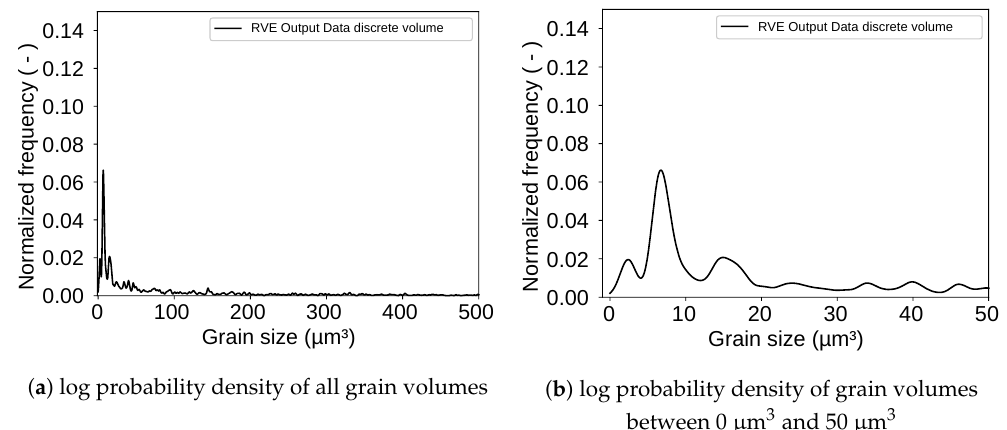
Figure 8. Log probability density of grain volumes shows that most grain volumes are in the range between 0 µ m 3 and 50 µ m 3